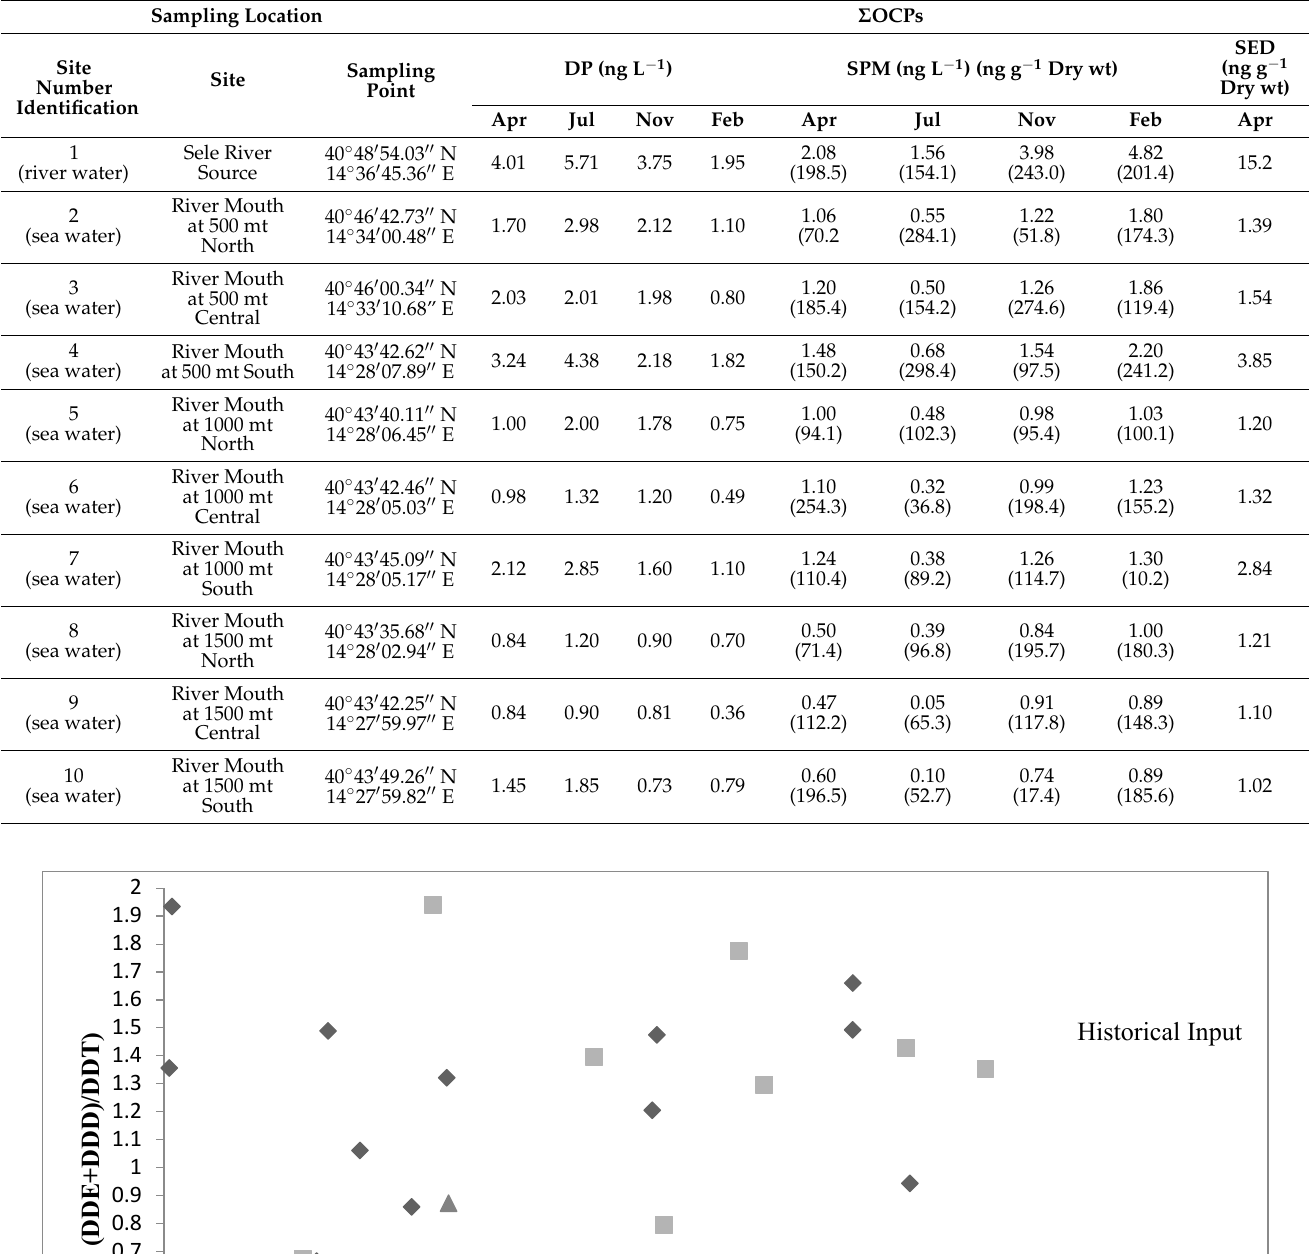
Table 2. Total OCPs concentrations in the three phases (DP, SPM, SED) analyzed for the samples collected from the Sele river, southern Italy.